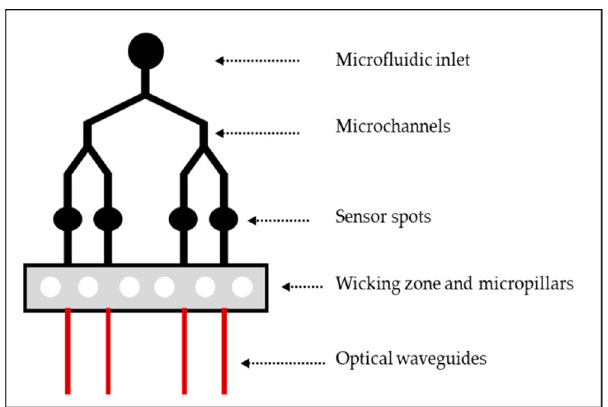
Figure 1. Schematic representation of the optofluidic platform.